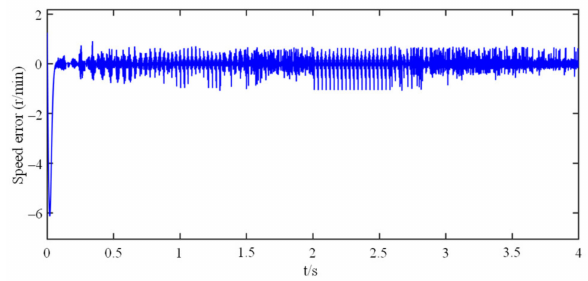
Figure 11. Speed error waveform at 500 r/min.